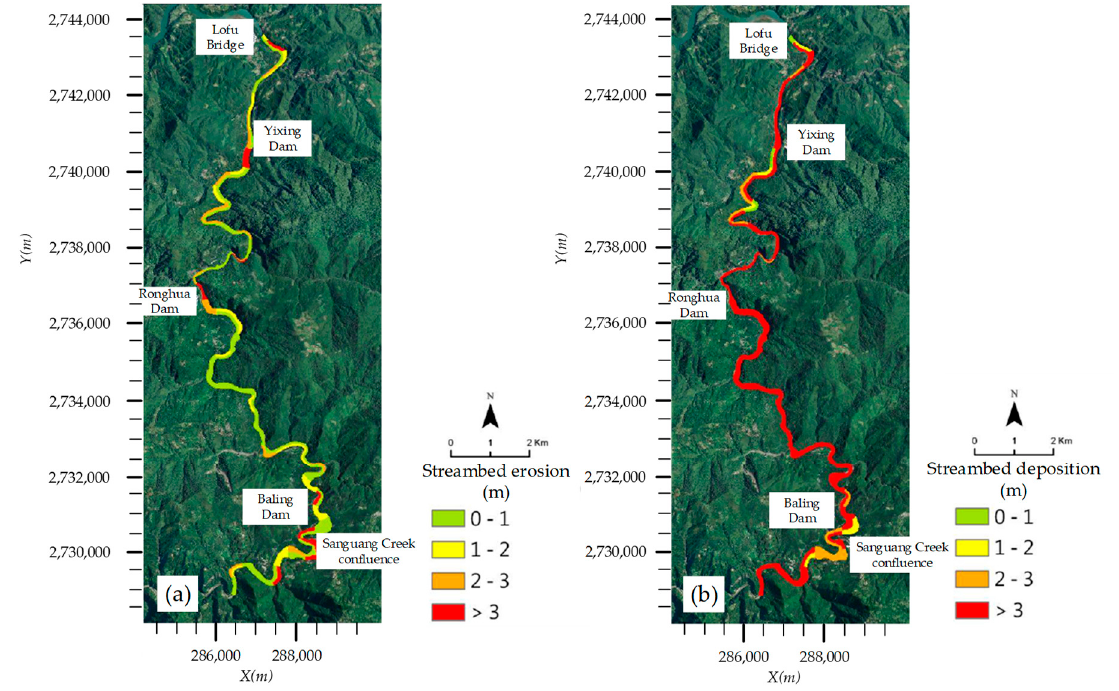
Figure 10. The sediment erosion ( a ) and deposition ( b ) amount of the study stream for the 200-year return period rainfall.